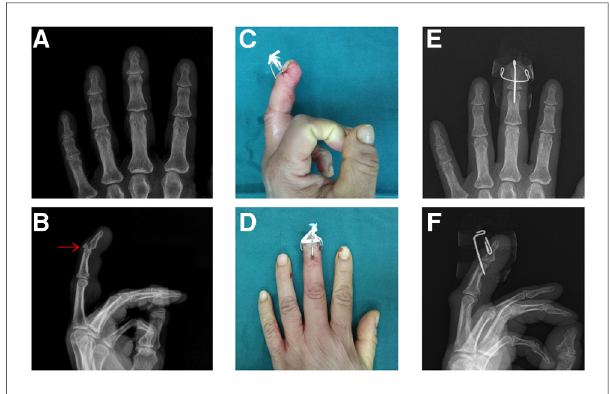
FIGURE 4 Preoperative and postoperative data of patient No.7. ( A,B ). Preoperative X-ray. ( C,D ). Postoperative X-ray. ( E,F ). Postoperative appearance.